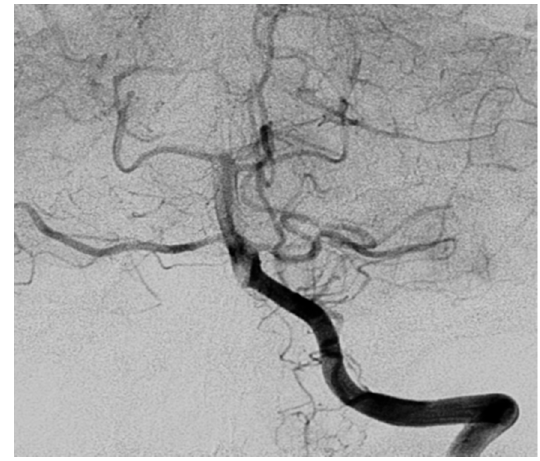
Figure 2. Digital subtraction angiography demonstrating right vertebral artery: changes in the caliber of the vessels of the right antero-inferior cerebellar artery as well as the tonsillar branch of the right postero-inferior cerebellar artery.